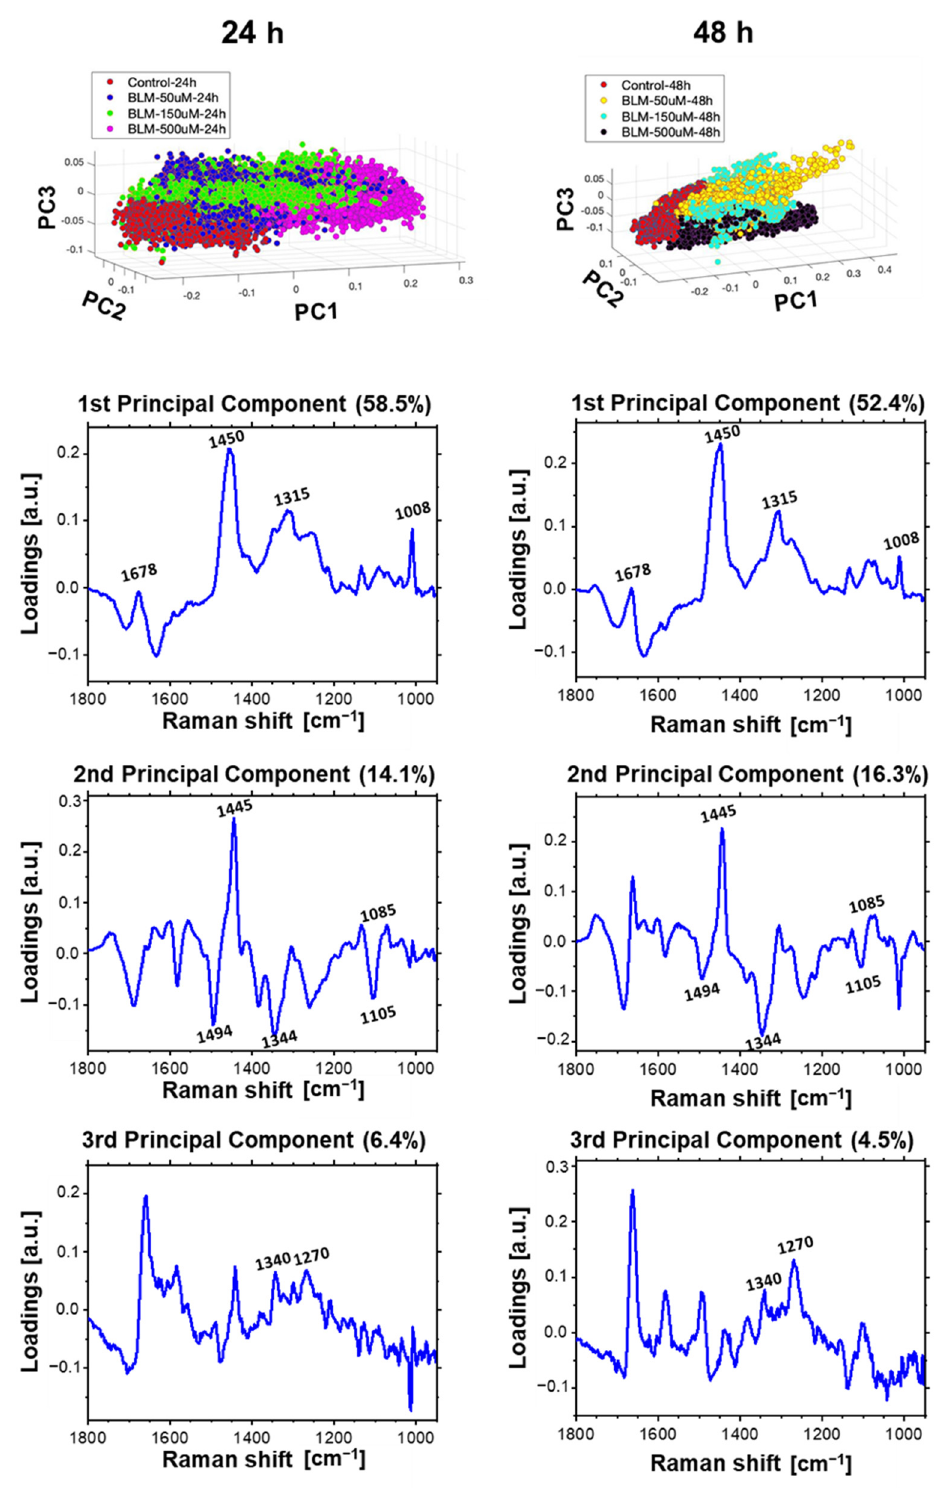
Figure 7. PCA of Raman spectra of cellular nuclei of HeLa cells incubated with bleomycin (control, 50 µ M, 150 µ M and 500 µ M) for 24 (left 3D image) and 48 h (right 3D image). For each incubation time, three first most significant loadings are